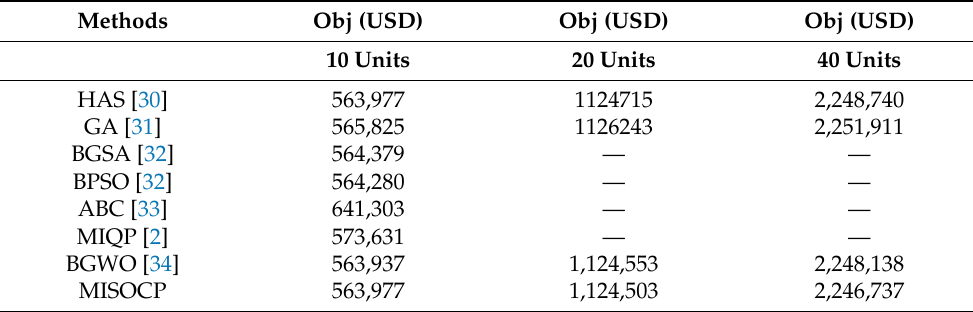
Table 4. Comparison of solution results without wind power and pollution emissions.